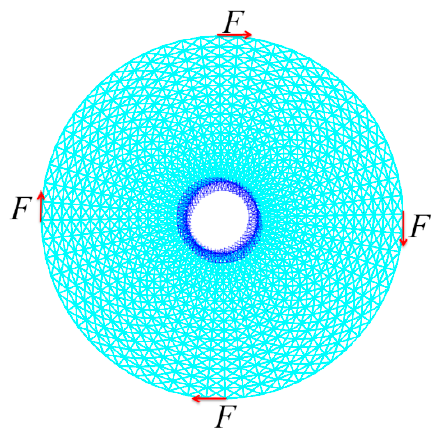
Figure 13. The initial lattice structure, loading and boundary conditions for hollow round.